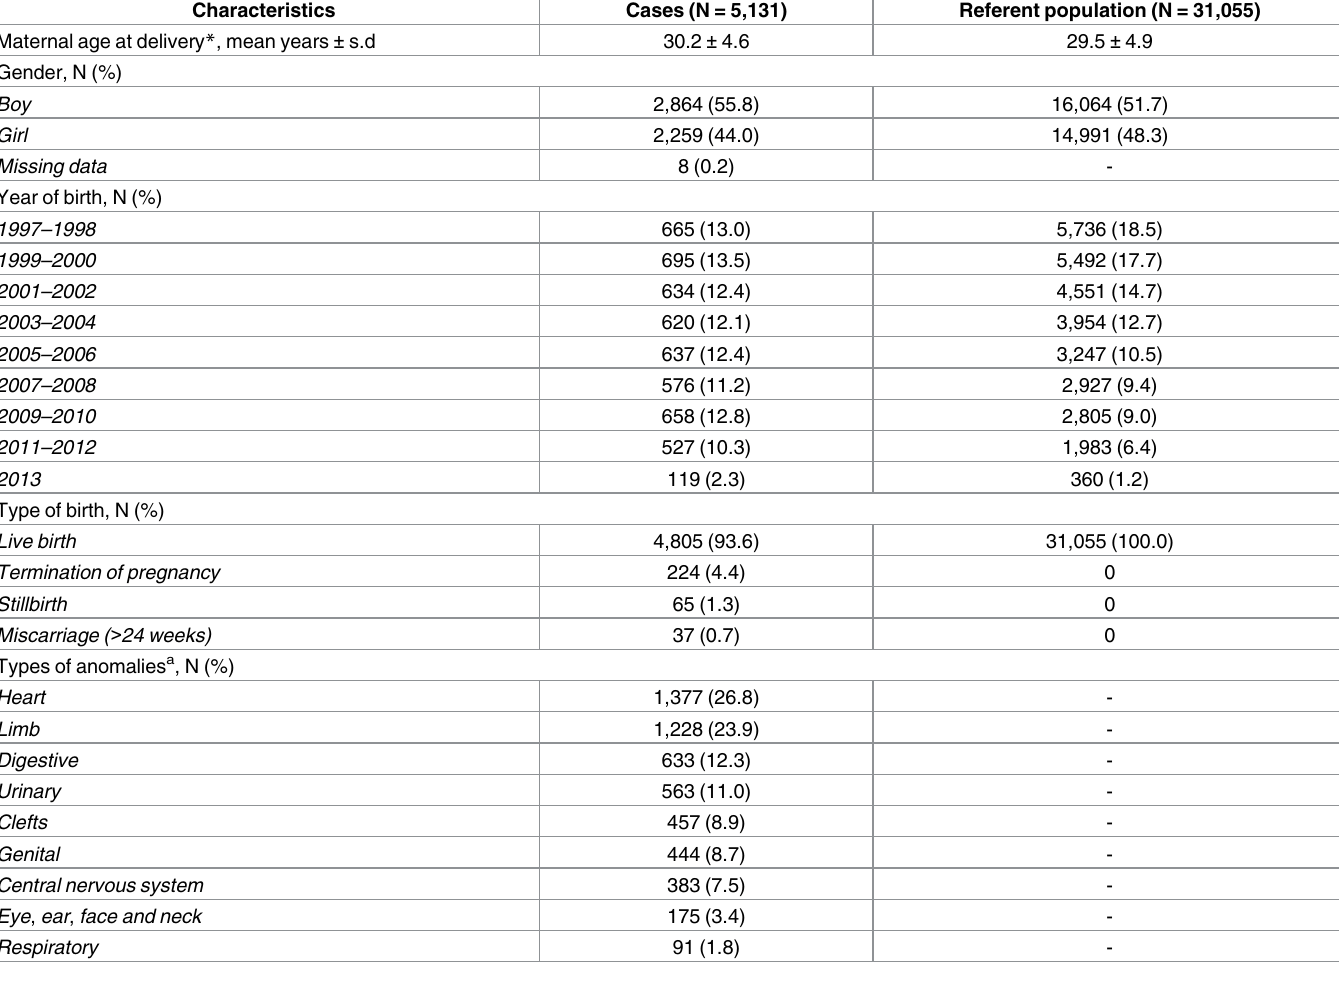
Table 1. Characteristics of children born to case mothers and referent population